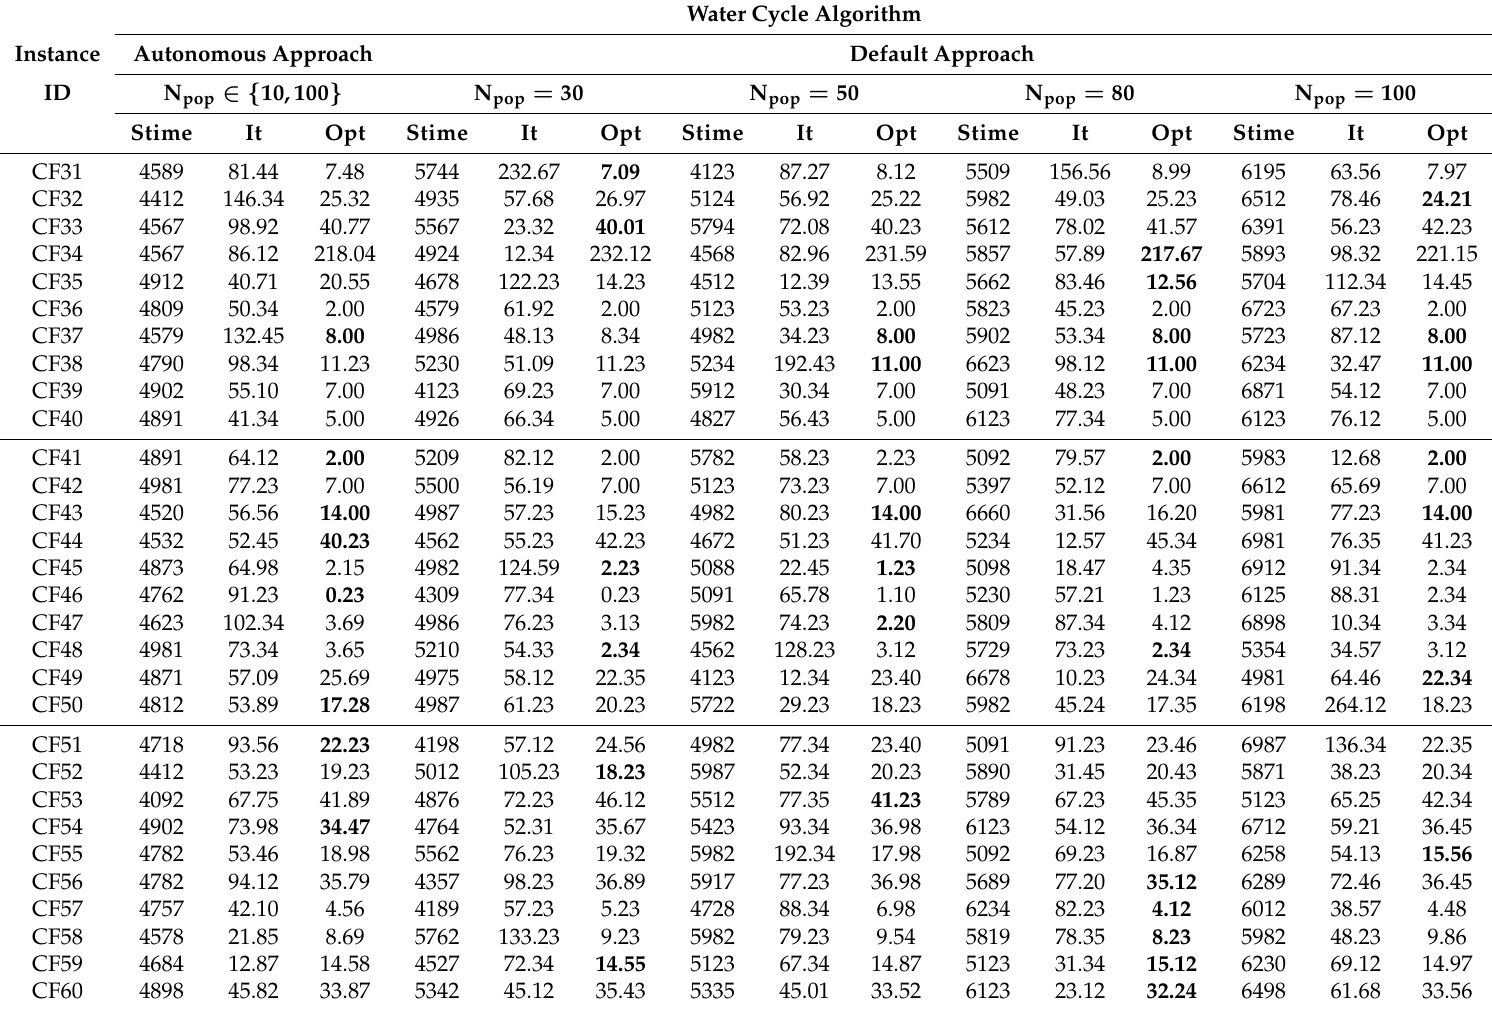
Table 10. Results solving complex instances